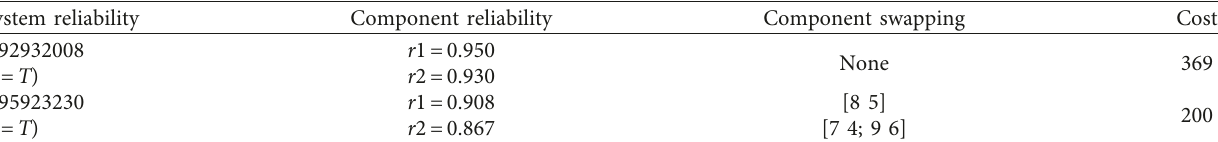
Table 10: Comparison of system and component parameters before and after optimization.